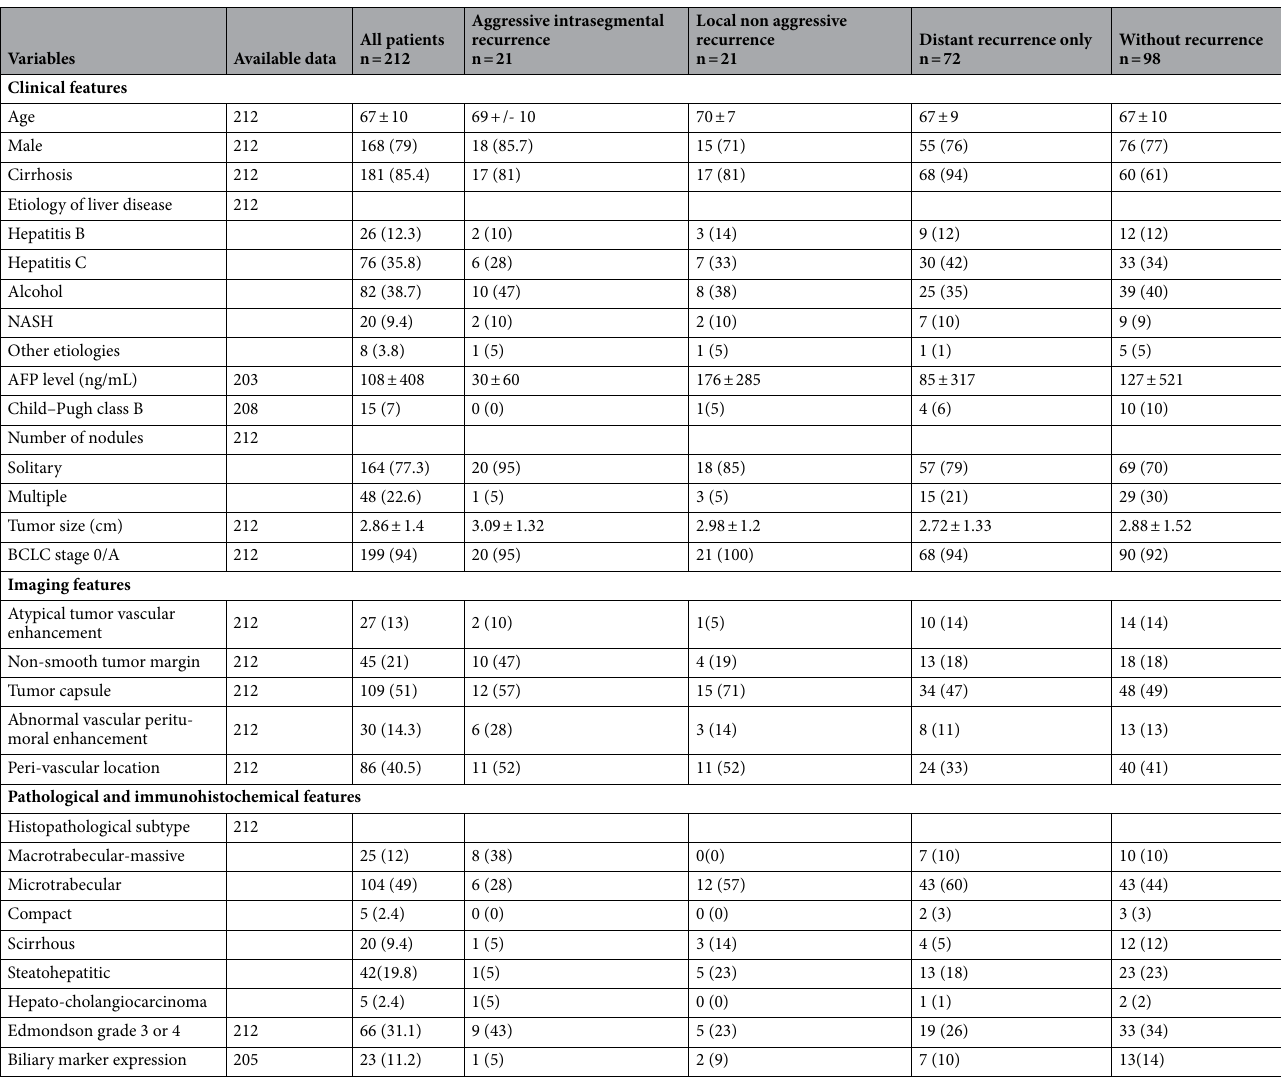
Table 1. Baseline features of patients according to the type of tumor recurrence. Results were expressed in numbers (%) or median ± standard deviation. AFP, alphafoetoprotein level; BCLC, Barcelona Clinic Liver Classification; NASH, non-alcoholic